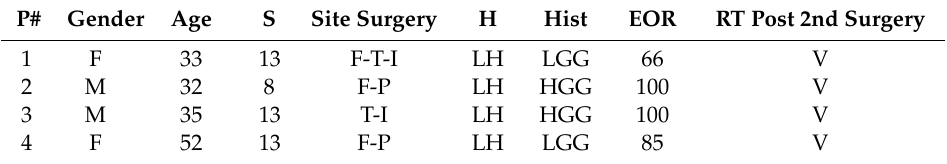
Table 1. Patients’ demographic and clinical data (H = hemisphere; P# = case number; M = male; F = female; S = years of schooling; Hist = histology; HGG = high grade glioma; LGG = low grade glioma, EOR = Extent of resection (%), RT = Radiotherapy post-2nd